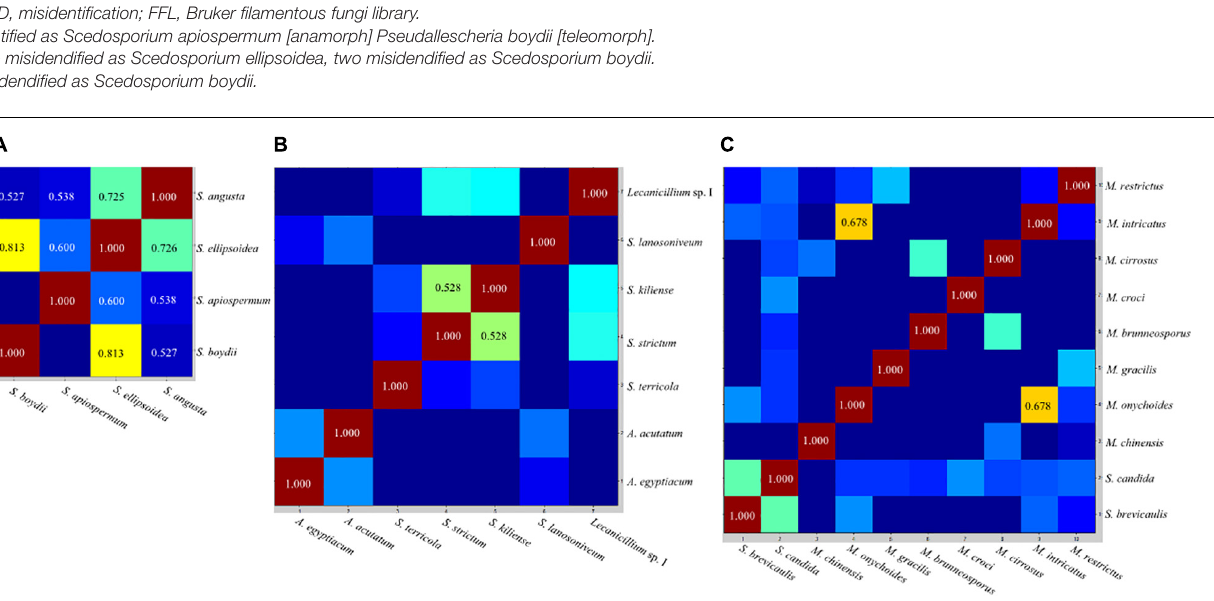
multilocus phylogenetic tree ( Figure 6 ). The MSP dendrogram of Scopulariopsis and Microascus spp. clustered 27 isolates to the Scopulariopsis clade and Microascus clade ( Figure 7 ). Isolates of M. gracilis and M. croci clustered in one subclade, whereas isolates of M. onychoides and M. intricatus clustered in